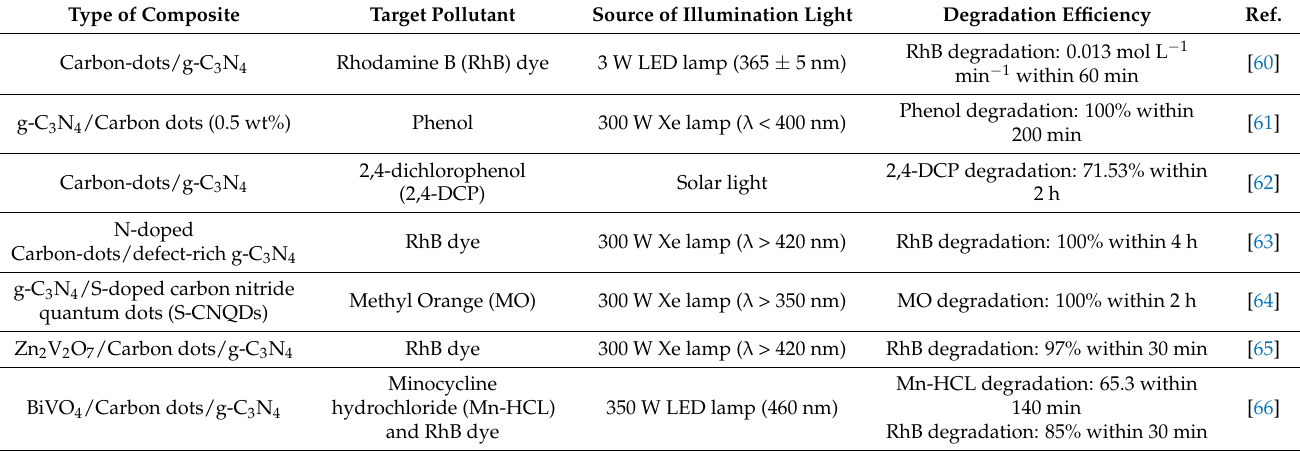
Table 1. Carbon quantum dots/g-C 3 N 4 -based photocatalysts for pollutant degradation under vari- ous